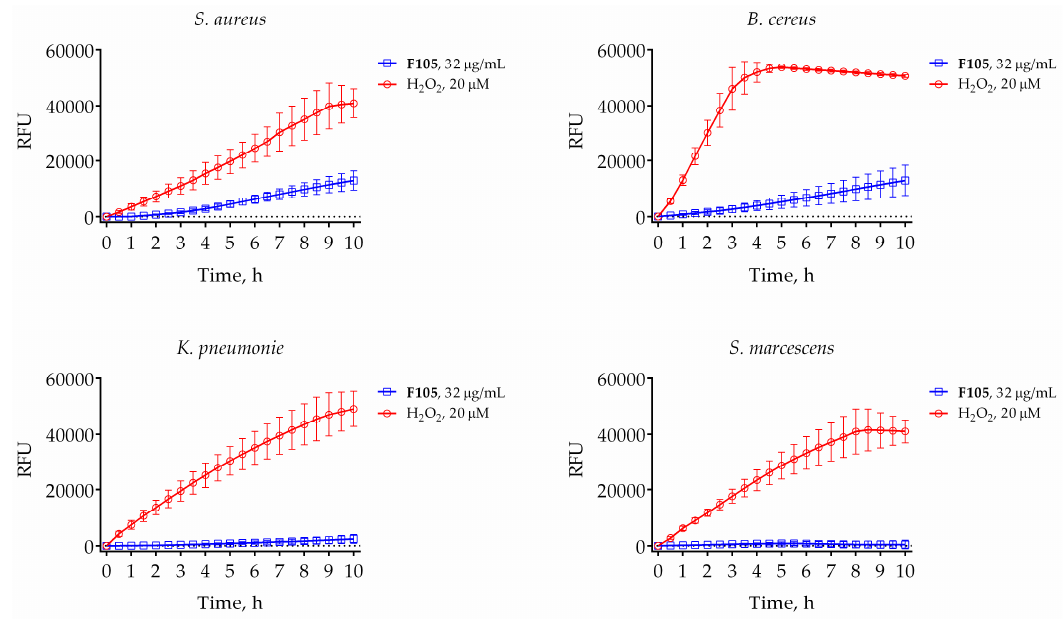
Figure 5. Dynamics of reactive oxygen species (ROS) production in bacteria induced by 20 µ M of hydrogen peroxide (red line) or 32 µ g/mL of F105 (blue line). Black line stands for untreated control cells. Bacterial cells were grown for 18 h, harvested, and washed with PBS. Cells were re-suspended until the final density of 10 5 CFU/mL in PBS supplemented with 2 (cid:48) ,7 (cid:48) -dichlorofluorescin diacetate (DCFDA) (5 µ M). After 30 min of pre-incubation at 25 ◦ C, 32 µ g/mL F105 or 20 µ M H 2 O 2 were added and the fluorescence was measured for 9 h with 5-min time intervals.